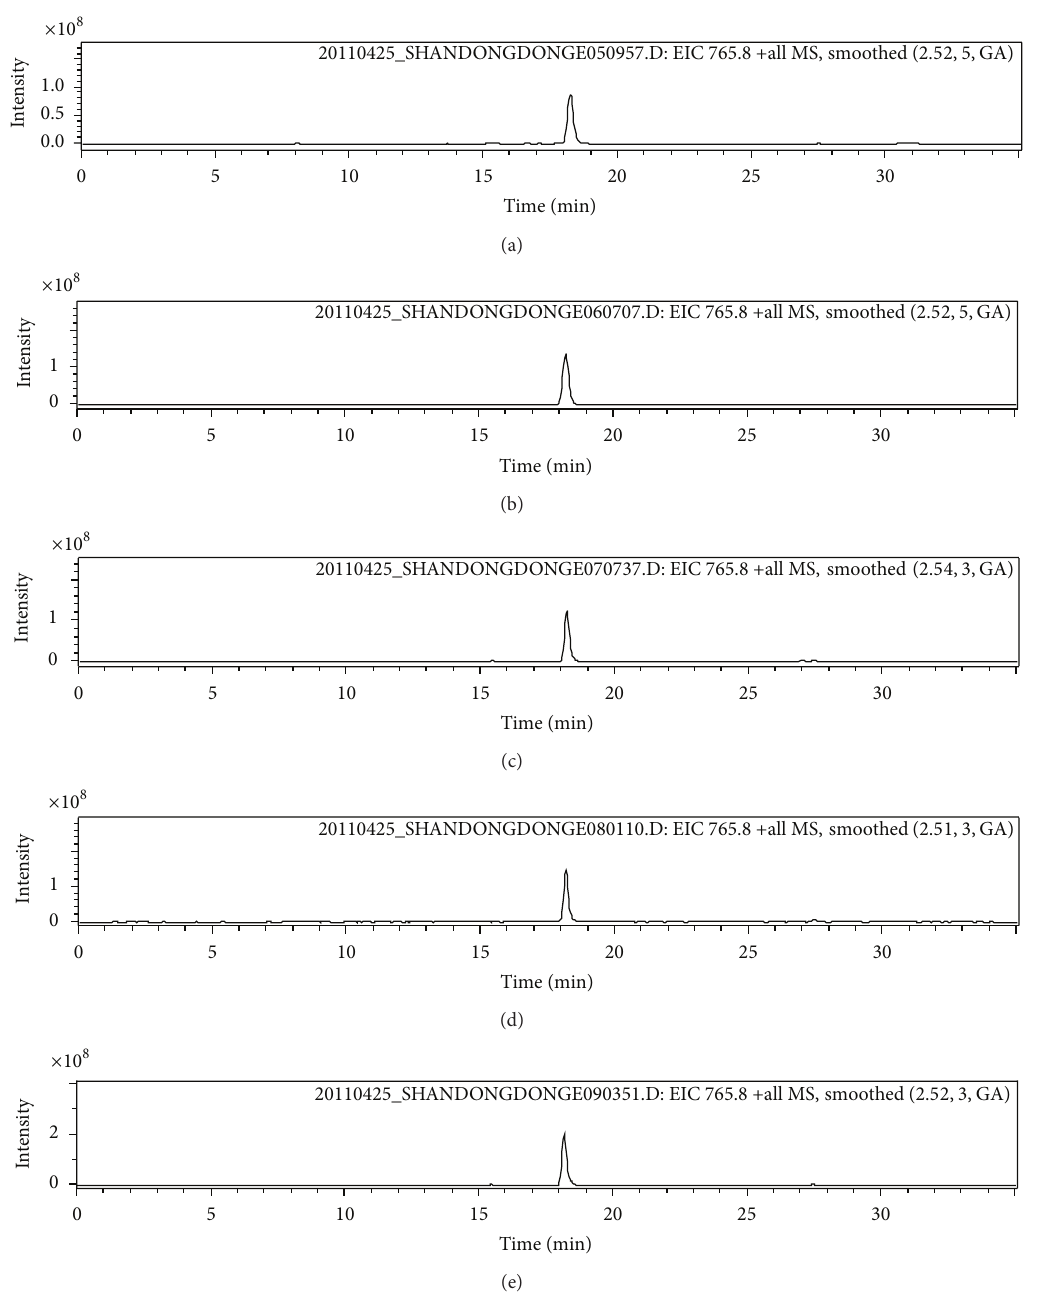
Figure 1: Doubly charged selected ion chromatograms obtained from the tryptic digests analysis of five donkey-hide gelatins.